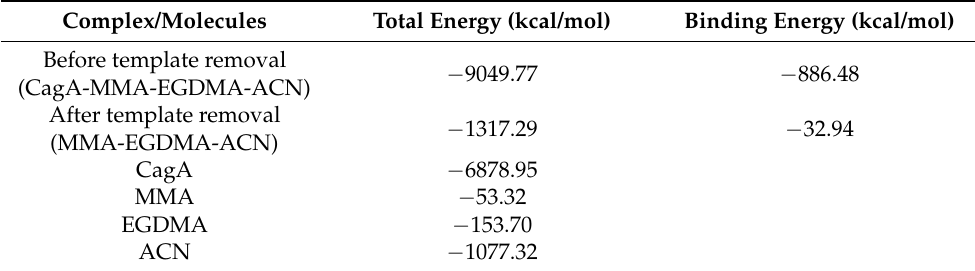
Table 3. Total energy and binding energy of the MIP prepolymerization system.